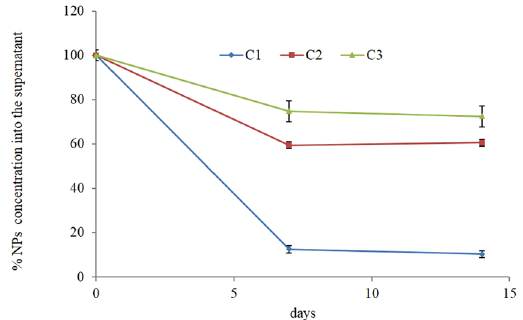
Figure 4. CNP colloidal stability over time. C1, C2, and C3 sample residual concentration into the supernatant after 7 and 14